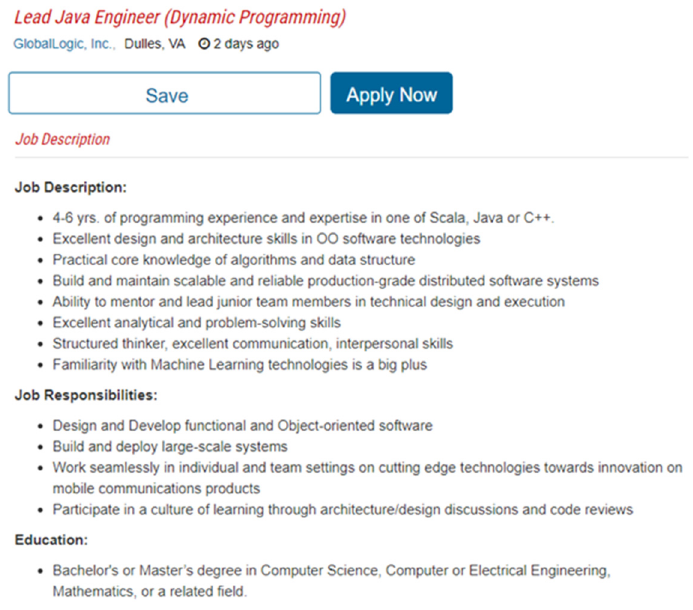
Figure 5. Sample job advertisement on a job portal www.dice.com (accessed on 20 March 2021).